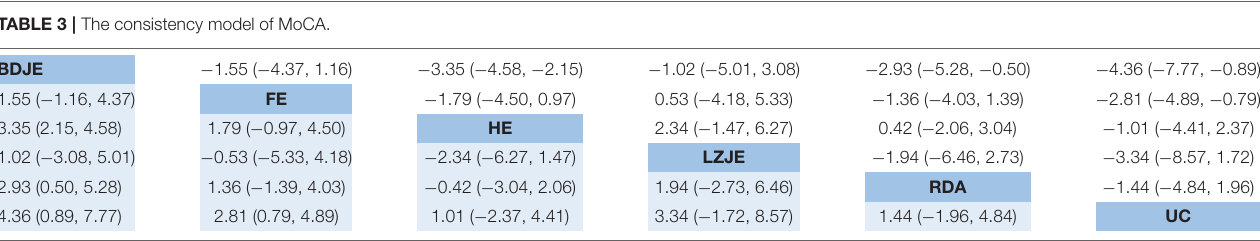
TABLE 3 | The consistency model of MoCA.